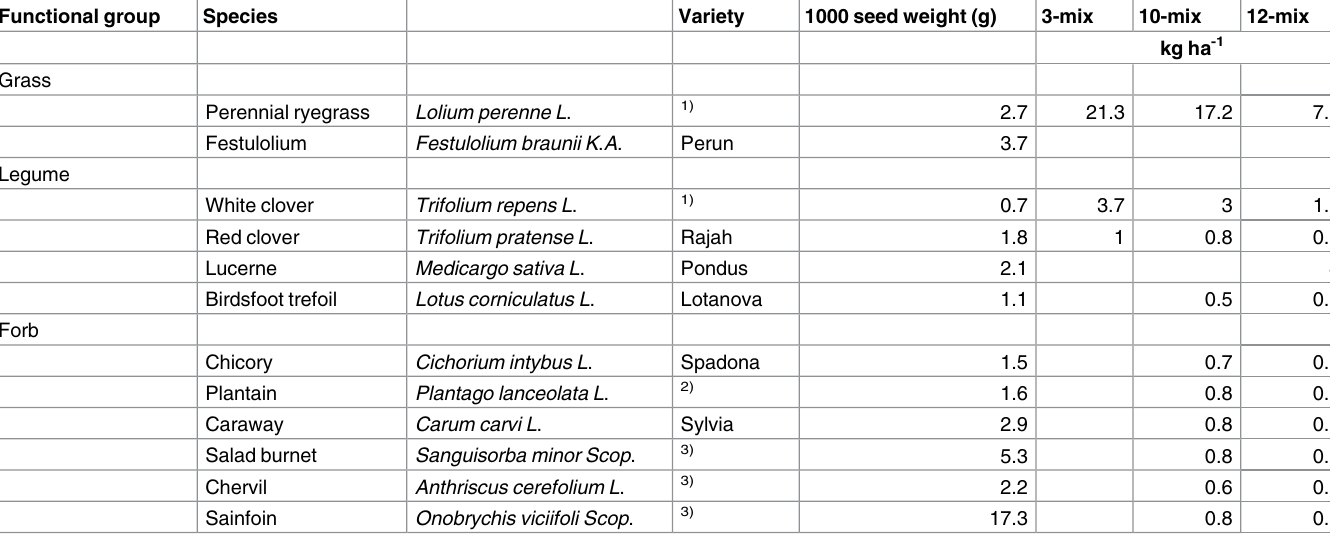
Table 1. Species included in the experiment, their functional group classification, the variety planted, and seed amount for the three mixtures. Functional group